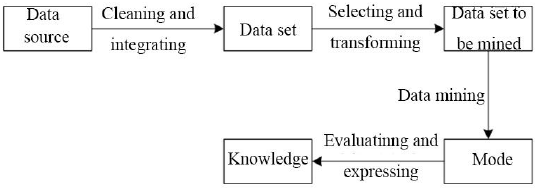
Figure 1: Data mining process